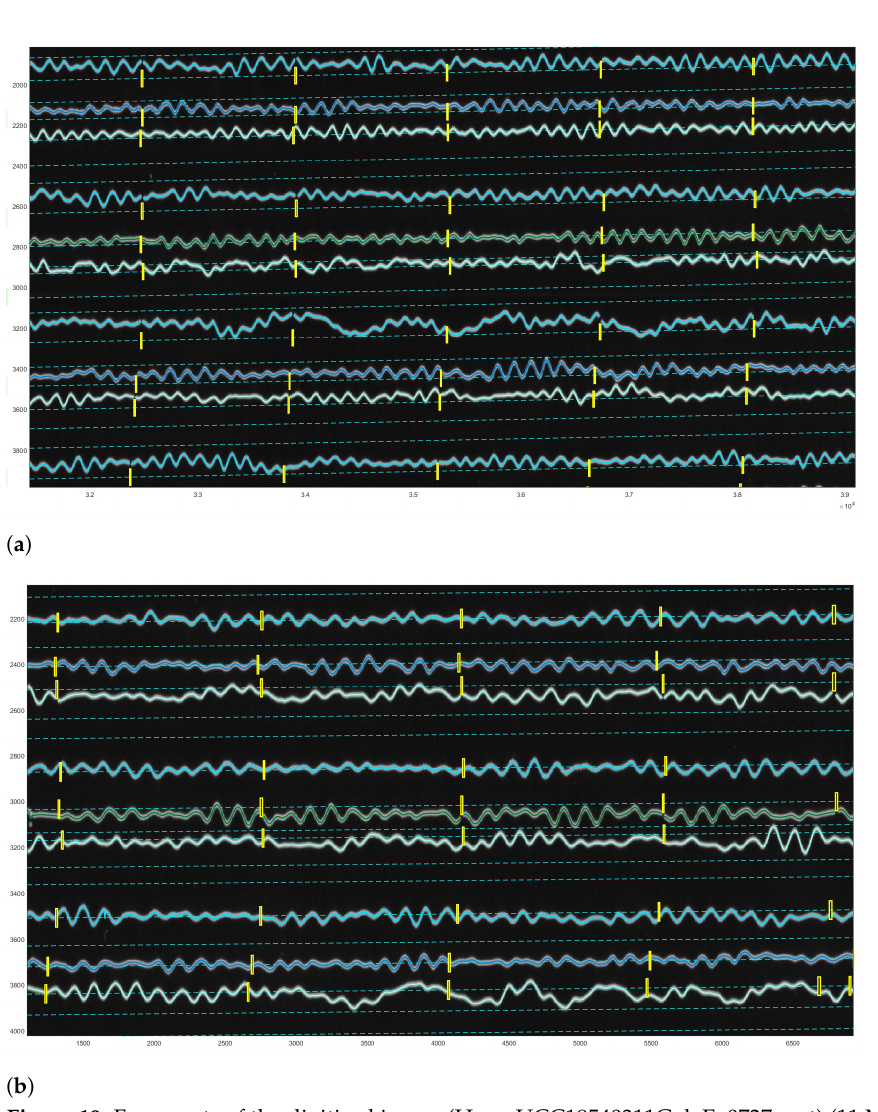
Figure 19. Fragments of the digitised image (Here: UCC19540311Gal_E_0727.mat) (11 March 1954). ( a ) Scanning of trace lines on the digitised image (Here: UCC19540311Gal_E_0727.mat). ( b ) Separation of traces and time gaps by filtering (time gap setup as ‘ − 12’ in this